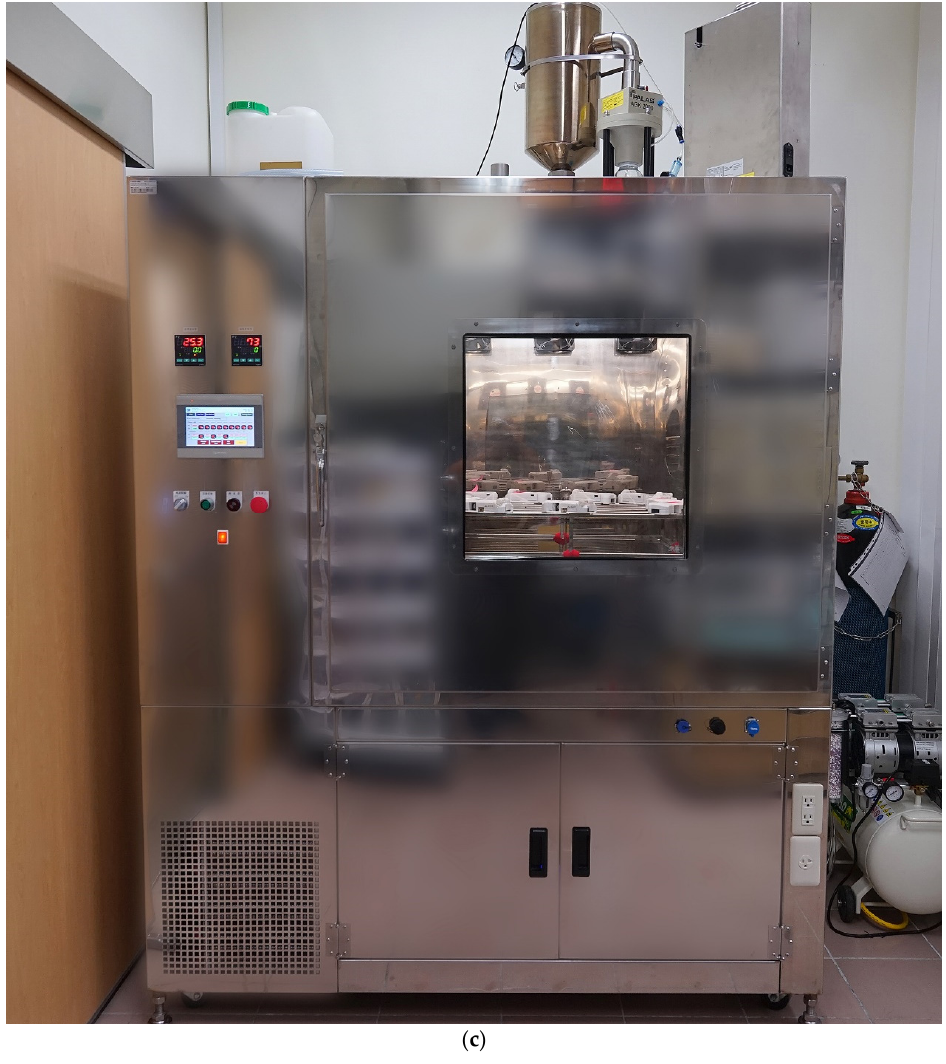
Figure 2. Side-by-side comparisons inside ( a ) a hood with 6 AS-LUNG-P sets, ( b ) a hood with 4 AS- LUNG-O sets, and ( c ) a chamber with 9 AS-LUNG-P